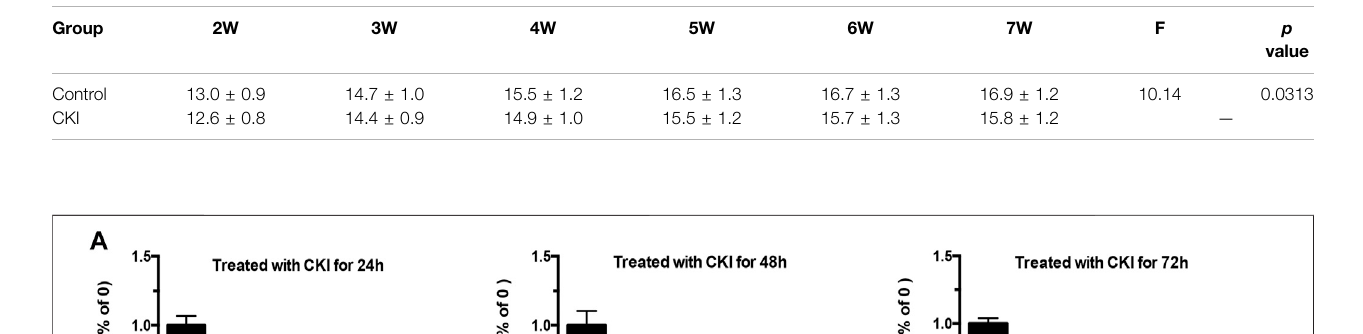
Frontiers in Pharmacology |